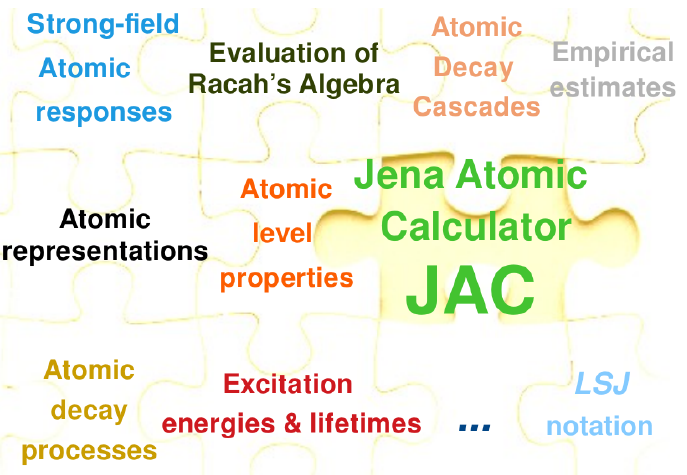
Figure 2. Overview of the J AC toolbox [36] for calculating atomic and ionic structures, processes and cascades, based on Dirac’s equation and the MCDHF method. This toolbox facilitates a variety of relativistic computations as briefly shown in this jigsaw puzzle. In this work, J AC is especially applied to predict the excitation energies and level properties of open d - and f -shell